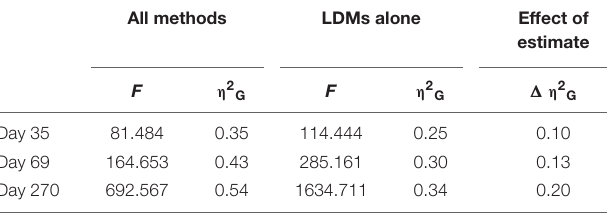
TABLE 1 | Repeated measures ANOVA results.